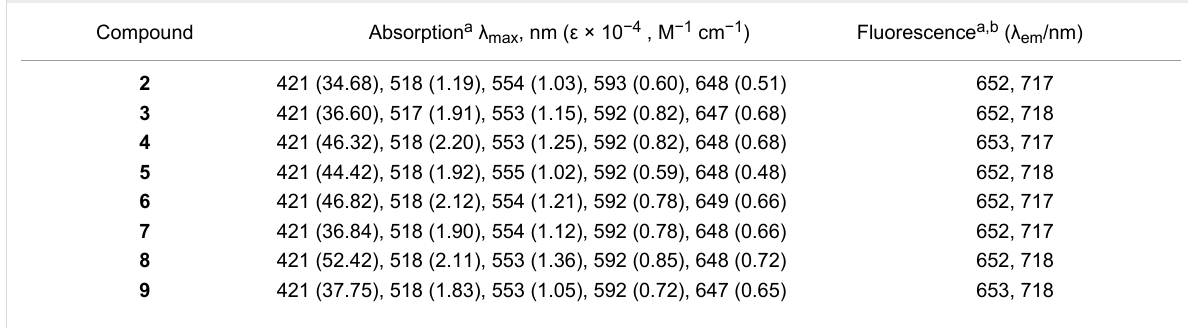
Table 1: Electronic absorption and emission data of porphyrins ( 2 – 20 ).